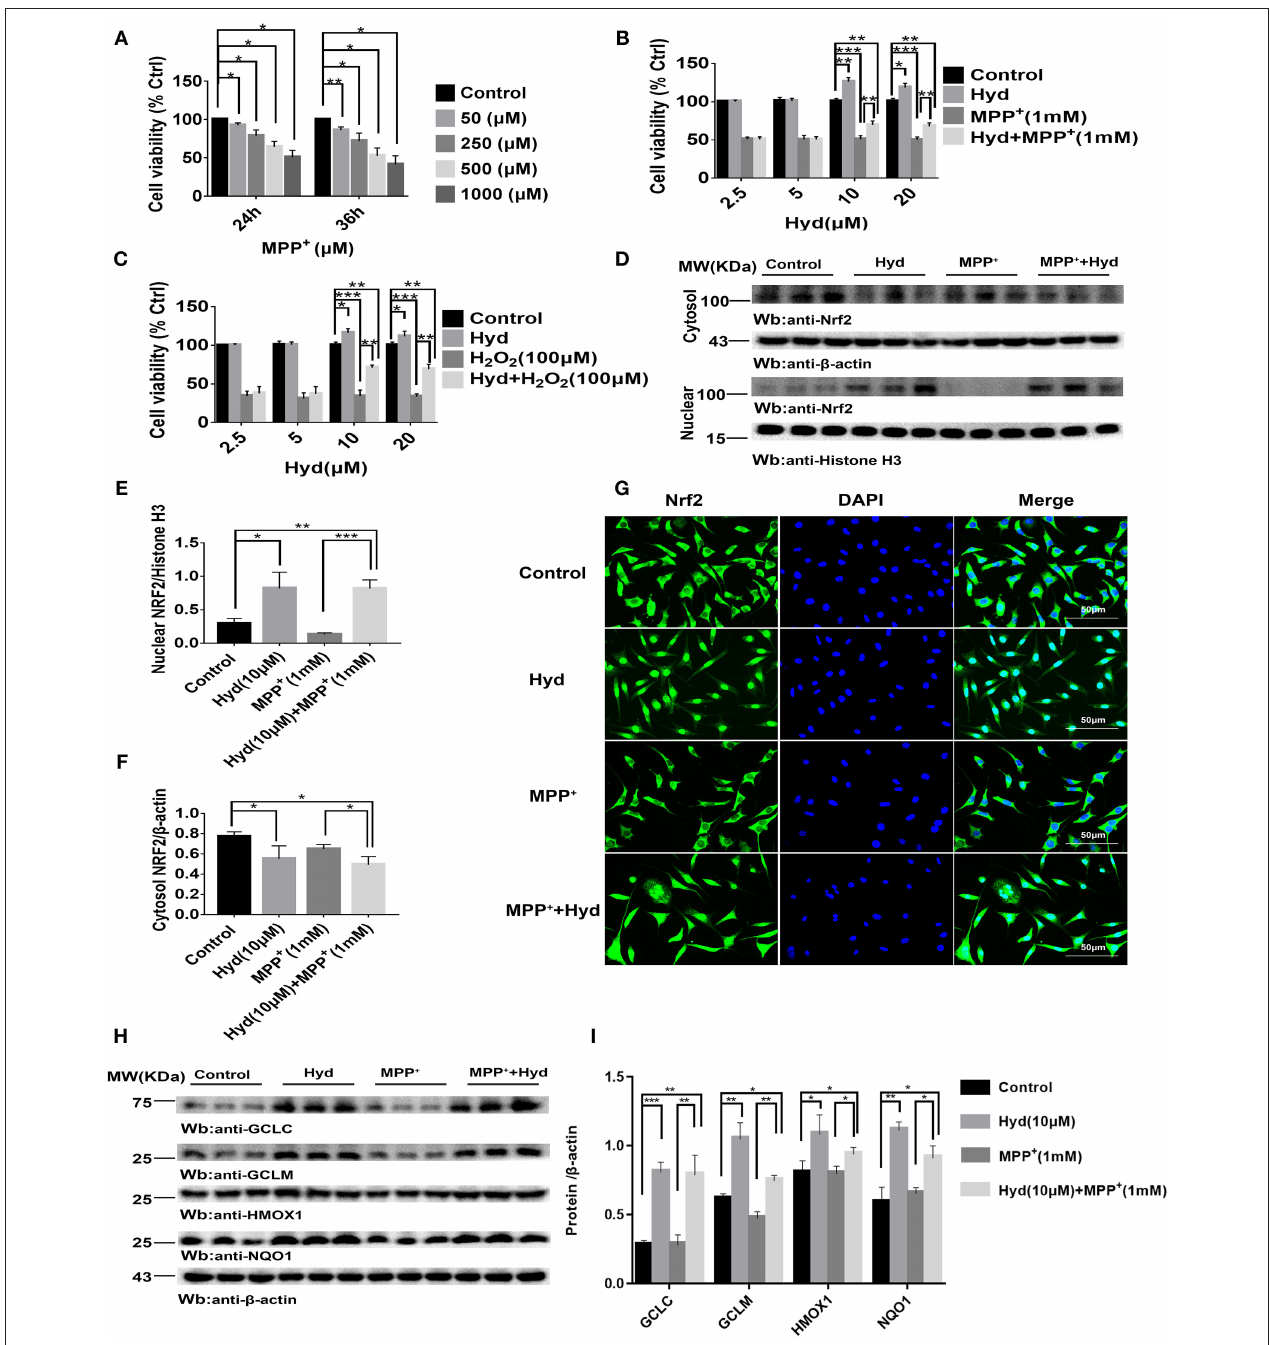
FIGURE 1 | Hydralazine prevents the MPP + and H 2 O 2 -induced cell death in SH-SY5Y cells, and activates Nrf2-ARE signaling in both treated and non-treated MPP + cells in vitro . SH-SY5Y cells were incubated with various concentrations of MPP + for 24, 36h (A) . Cell viability was determined by CCK-8 assay. * p < 0.05, ** p < 0.01, n = 6, compared with the two indicated groups. SH-SY5Y cells were incubated with or without hydralazine (2.5, 5, 10, 20 µ M) in the absence or presence of 1mM MPP + for 24h (B) . The viability of cells under MPP + -mediated cytotoxicity was significantly improved with hydralazine (10 and 20 µ M) treatment. * p < 0.05, ** p < 0.01, *** p < 0.001, n = 6, significant difference between the two indicated groups. SH-SY5Y cells were incubated with or without hydralazine (2.5, 5, 10, 20 µ M) in the absence or presence of H 2 O 2 (100 µ M) for 24h (C) . The viability of cells under H 2 O 2 -induced cytotoxicity was significantly improved with hydralazine (10 and 20 µ M) treatment. * p < 0.05, ** p < 0.01, *** p < 0.001 n = 6, significant difference between the two indicated groups. The results of immunofluorescence and western blot analysis indicated Nrf2 translocated to the nucleus with hydralazine treatment when exposured to MPP + or not in SH-SY5Y (D–G) . Scale bar = 500 µ m. Treated cells were subjected to cell fractionation and western blot analysis. β -actin or Histonen H3 served as a loading control. * p < 0.05, ** p < 0.01, *** p < 0.001, n = 6, significant difference between the two indicated groups. Hydralazine induces expression of Nrf2-dependent antioxidant enzymes measured by western blot analysis (H,I) . * p < 0.05, ** p < 0.01, *** p < 0.001, n = 6, significant difference between the two indicated groups. Data were presented as mean ± SEM.